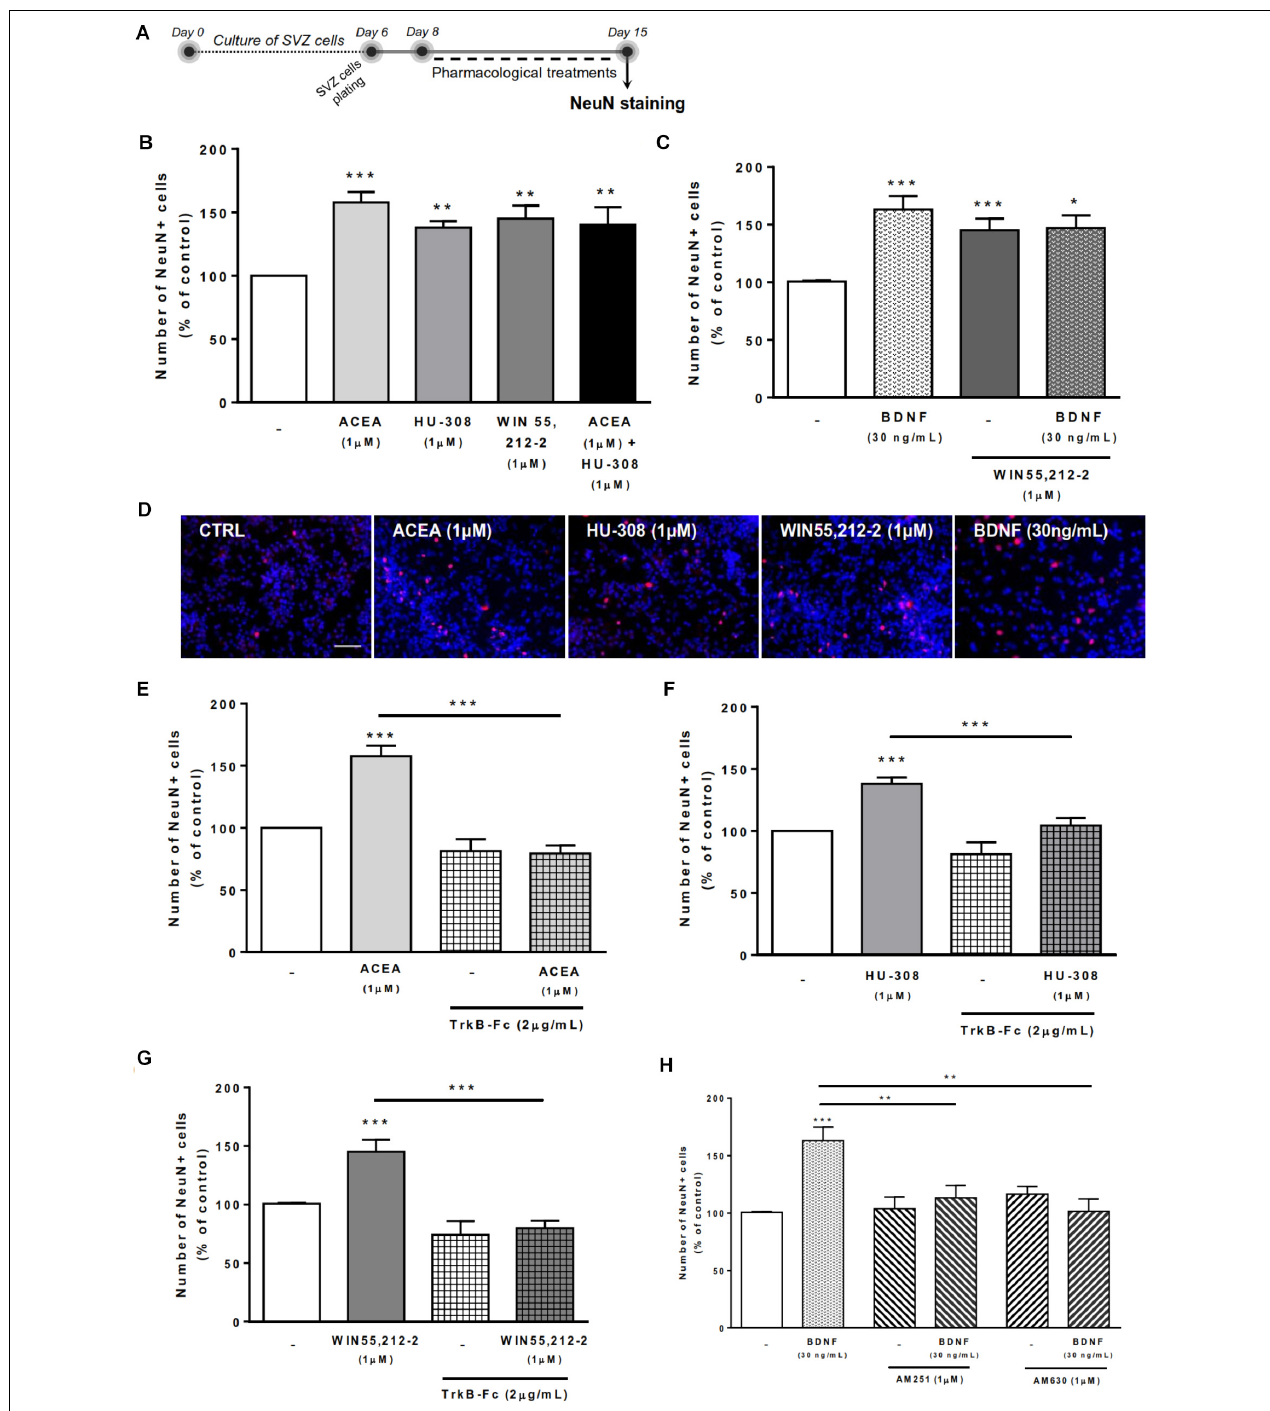
FIGURE 3 | Cannabinoid receptor crosstalk with BDNF modulates SVZ neuronal differentiation. Cannabinoid receptor activation promoted SVZ neuronal differentiation, an effect dependent on the presence of endogenous BDNF. Similarly, BDNF effect upon SVZ neuronal differentiation was abolished by CB1R or CB2R antagonism. (A) Schematic representation of the experimental protocol. Day 0 represents the day of cultures; at Day 6 SVZ neurospheres were plated for 48h and at Day 8 cells were exposed to pharmacological treatments for further 7 days (Day 15). (B,C,E–H) Bar graphs depict the number of NeuN-positive cells. Values were normalized to the control mean for each experiment and are represented as mean ± SEM. Control was set to 100%. n = 5–24. ∗ p < 0.05 and ∗∗∗ p < 0.001 using Dunnett’s multiple comparison test. (D) Representative fluorescent digital images of cells immunopositive for NeuN (in red) and Hoechst 33342 staining (blue nuclei). Scale bar = 50 µ